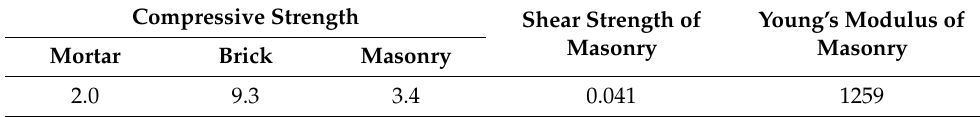
Table 2. Mechanical properties of the mortar, brick and masonry (unit: Mpa).